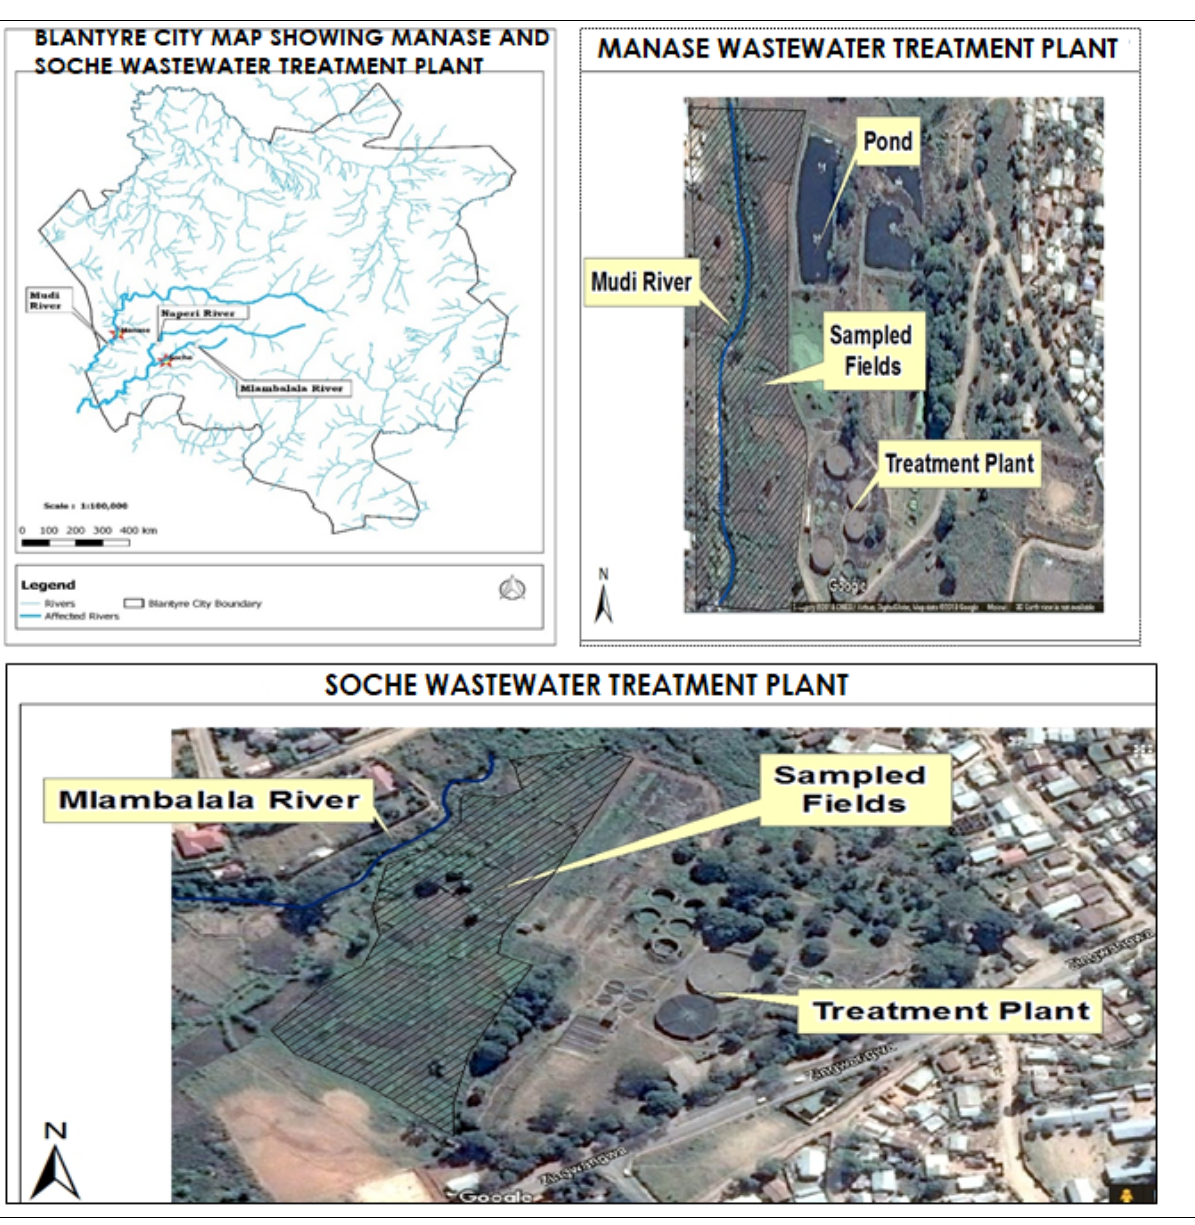
Figure 1. Map of Blantyre showing rivers that surround Manase and Soche Wastewater Treatment Plants and boundary of Blantyre city and aerial view showing sampled fields, the rivers, and positioning of the two WWTPs, respectively.